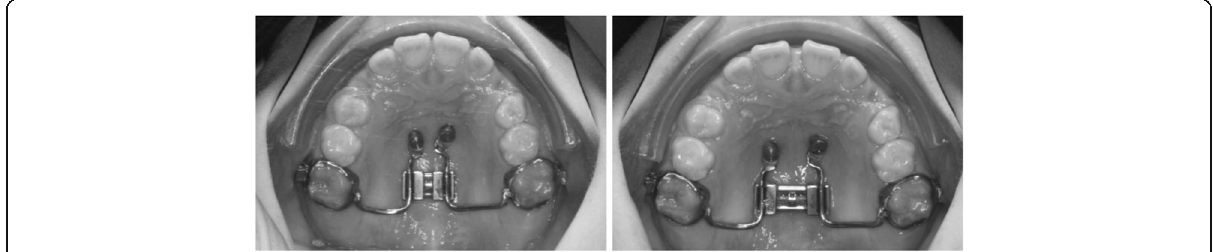
Fig. 2 Hybrid-Hyrax- before and after maxillary